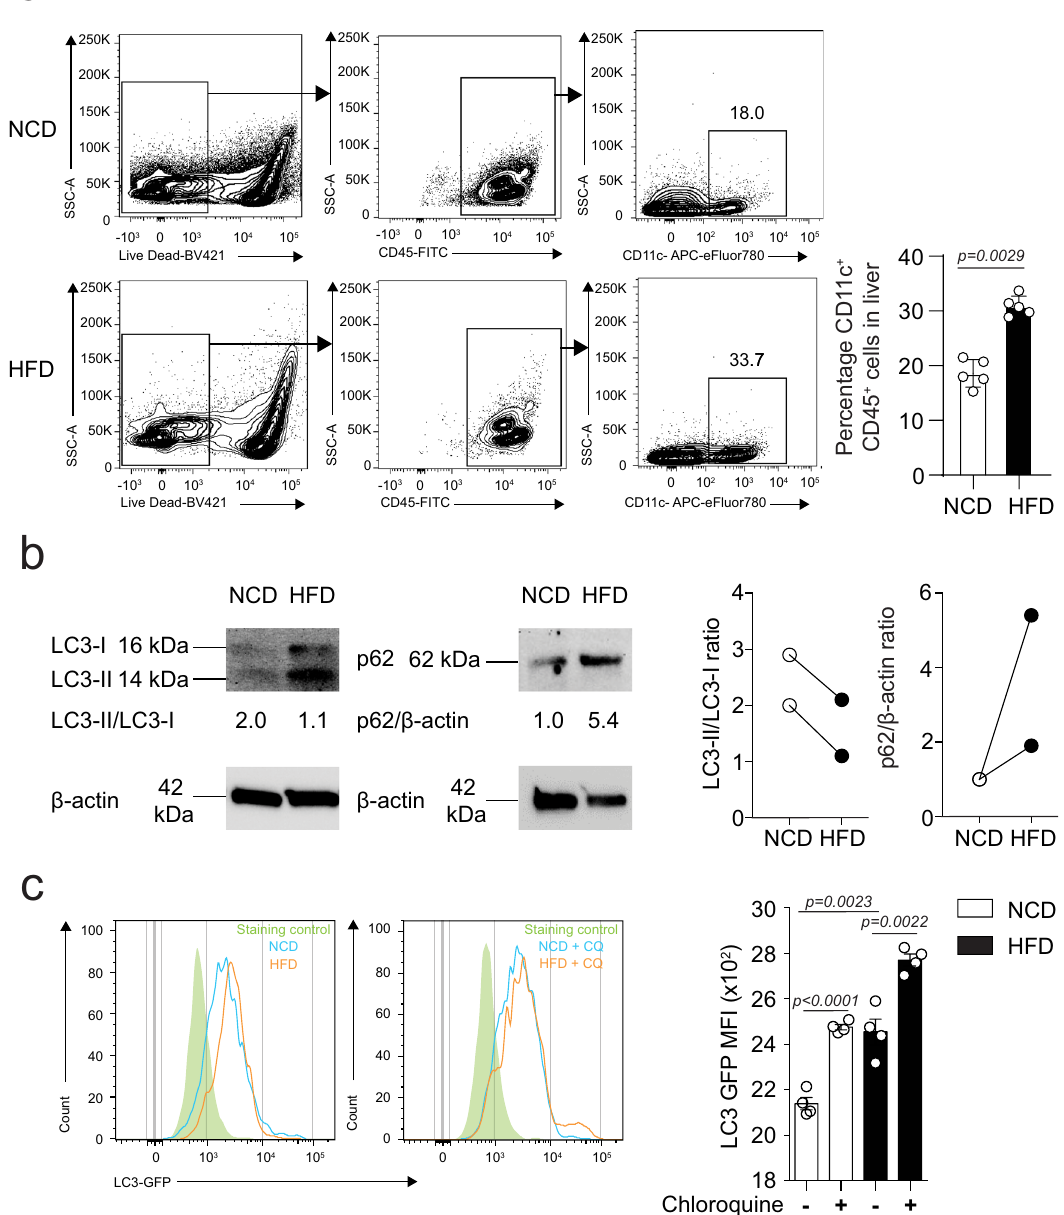
Fig. 2 HFD induces CD11c expression and impairs the autophagic fl ux in hepatic CD11c + cells. a Gating strategy of hepatic CD11c + CD45 + cells isolated from C57BL/6 mice fed NCD or HFD (left panel). Percentage of hepatic CD11c + CD45 + cells (right panel), n = 5 mice. b Western blot analysis of LC3-I/II and p62 levels in hepatic CD11c + cells isolated from C57BL/6 mice (NCD vs. HFD) (left panel showing LC3 bands and a middle panel showing p62 bands). Densitometric quanti fi cation of LC3II/LC3I ratio (normalized to β -actin) and p62/ β -actin (right panel), n = 2 independent experiments. c Flow cytometry quanti fi cation of LC3 expression in hepatic CD11c + cells isolated from C57BL/6 mice (NCD vs. HFD) and cultured for 15 h in the presence or absence of chloroquine (CQ at 25 μ M), n = 4 mice. Error bars are the mean ± SD, two-tailed Student ’ s t test. Experiments were performed at least two times. Source data are provided as a Source Data fi le.